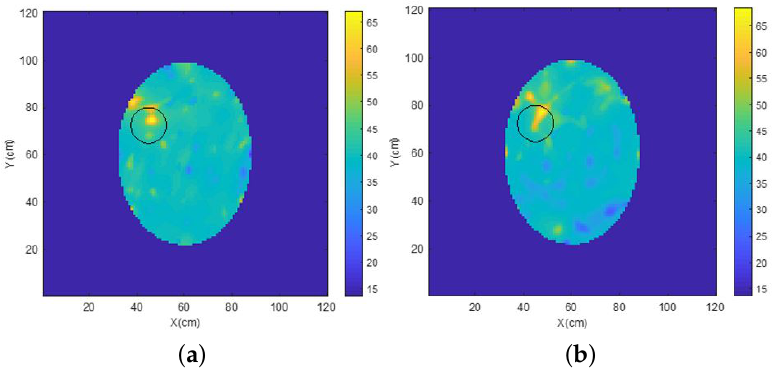
Figure 8. Frequency hopping reconstructions of the blood-mimicking target obtained from experi- mental data for the triangular patch antenna array ( a ) without MTS and ( b ) with MTS.